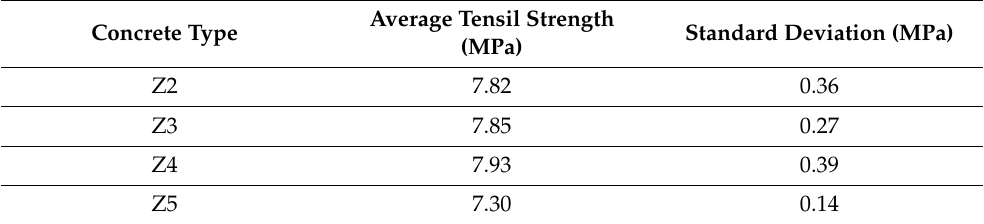
Table 12. Results of the tensile strength test at bending of the Z1 concrete beam depending on the reinforcing fibers used in the block supports.